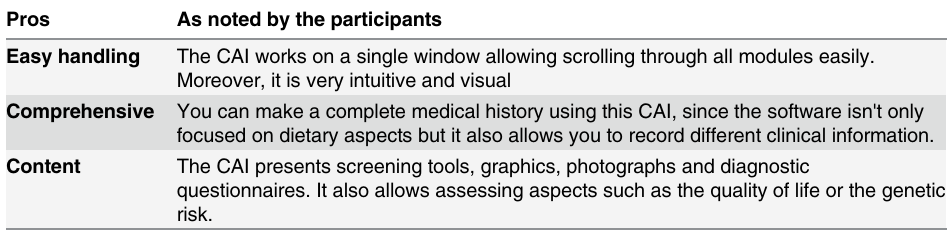
Table 4. Pros of the CAI in relation to other nutrition software.